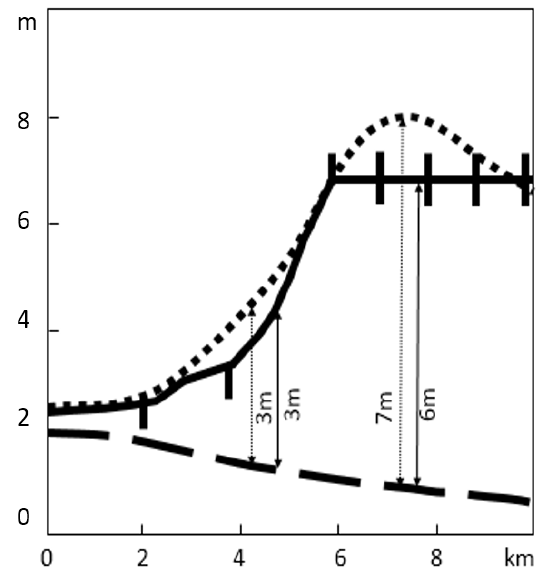
Figure 1. Schematic partial transect of a peat dome showing its original surface (dotted line), current surface (solid line) and peat base (long dashes). The location of isopachs (contours of equal peat thickness) are shown before (dotted line with arrows) and after (solid line with arrows) clearing, draining and crop planting. Deflation has increased the extent of peat < 3m deep - where regulations allow conversion of peatland. Roads and drains are indicated by vertical bars above and below the peat surface. Vertical exaggeration ×1000. Distances are measured from the edge of the peat dome (0.40 m